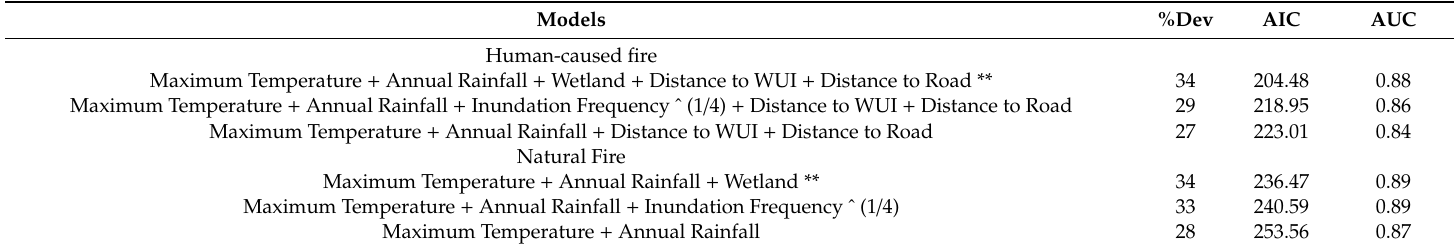
Table 4. Performance of multiple models for human-caused and natural